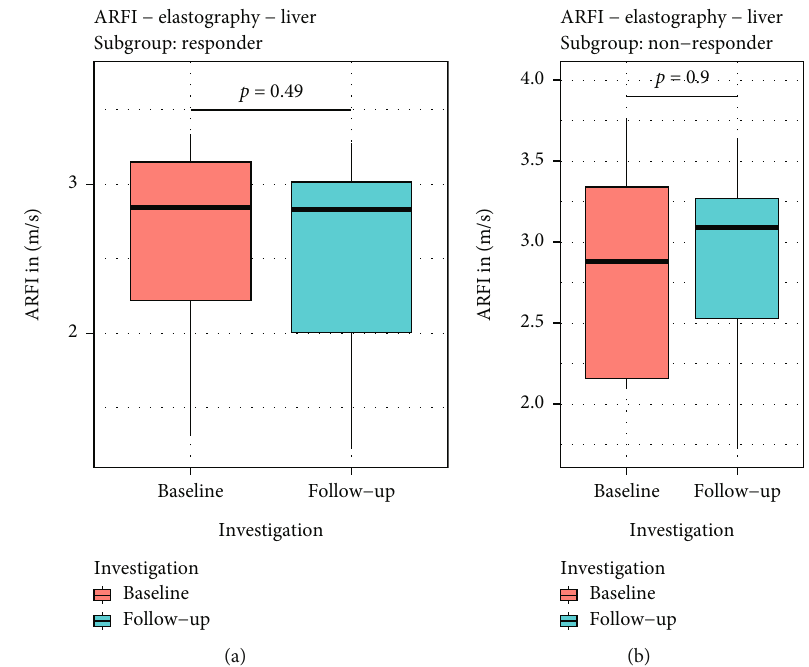
Figure 3: ARFI elastography results for liver sti ff ness (LSM) evaluation: LSM did not show any signi fi cant alterations dependent on response (a) or non-response (b) status de fi ned by corresponding HVPG results (red =baseline, blue=follow-up) (LSM =liver sti ff ness measurement; HVPG=hepatic venous pressure gradient).